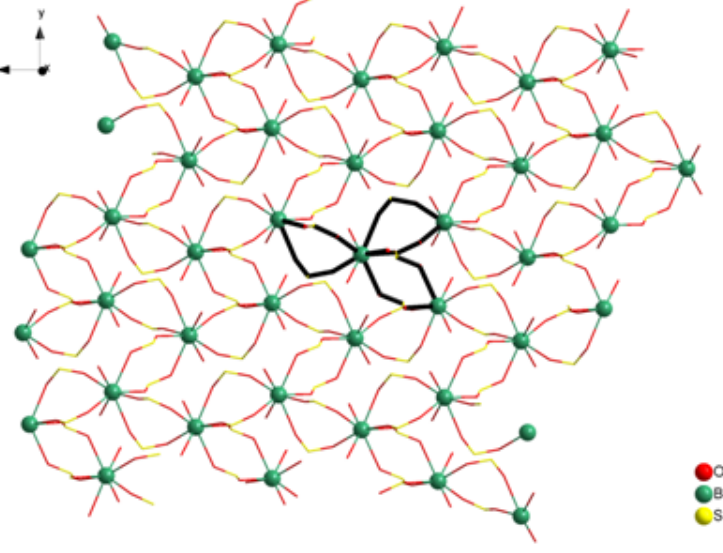
framework of 1 . The carbon and hydrogen atoms are omitted for Figure 2. The Bi–SO 3